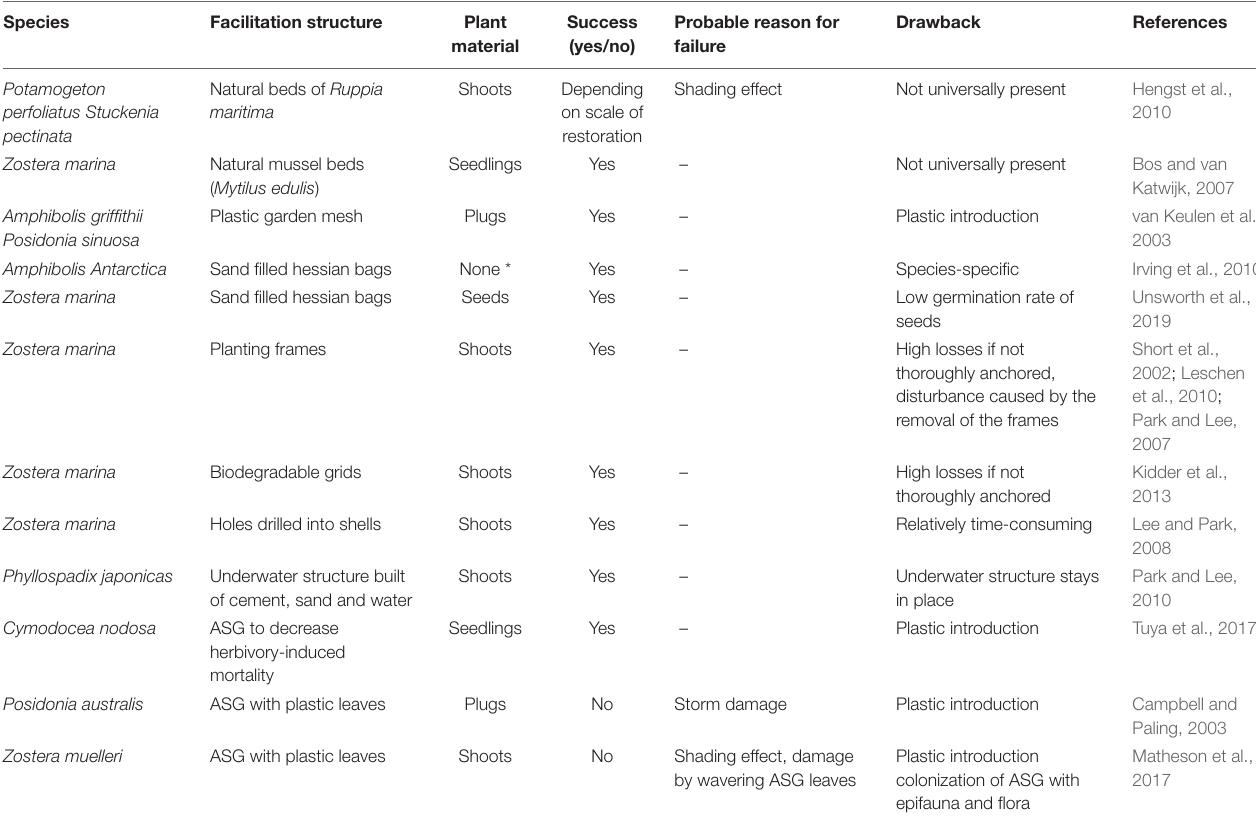
TABLE 1 | Overview of existing restoration trials using artificial